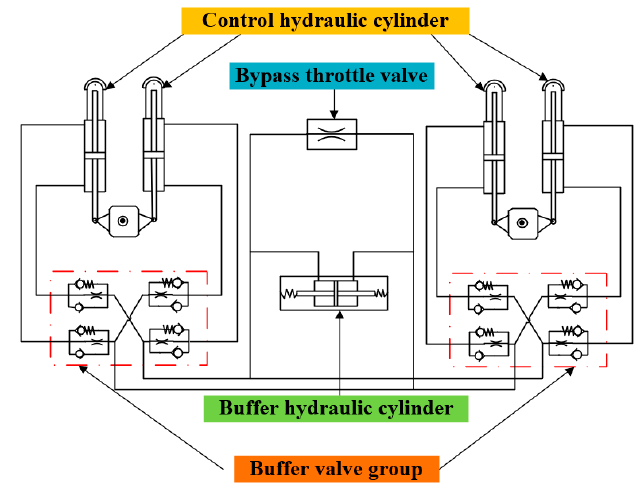
Figure 2. Simplified schematic diagram of hydraulic anti-kink system.